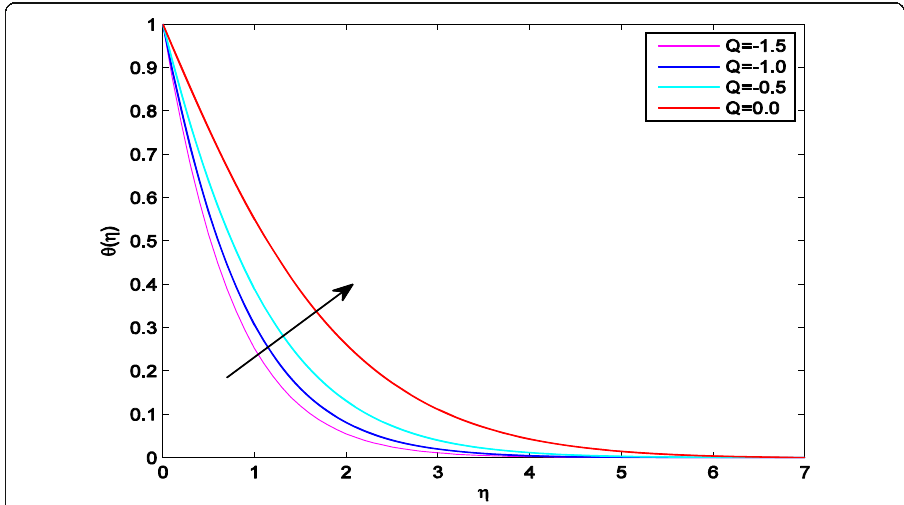
Fig. 16 Temperature graph for various values of